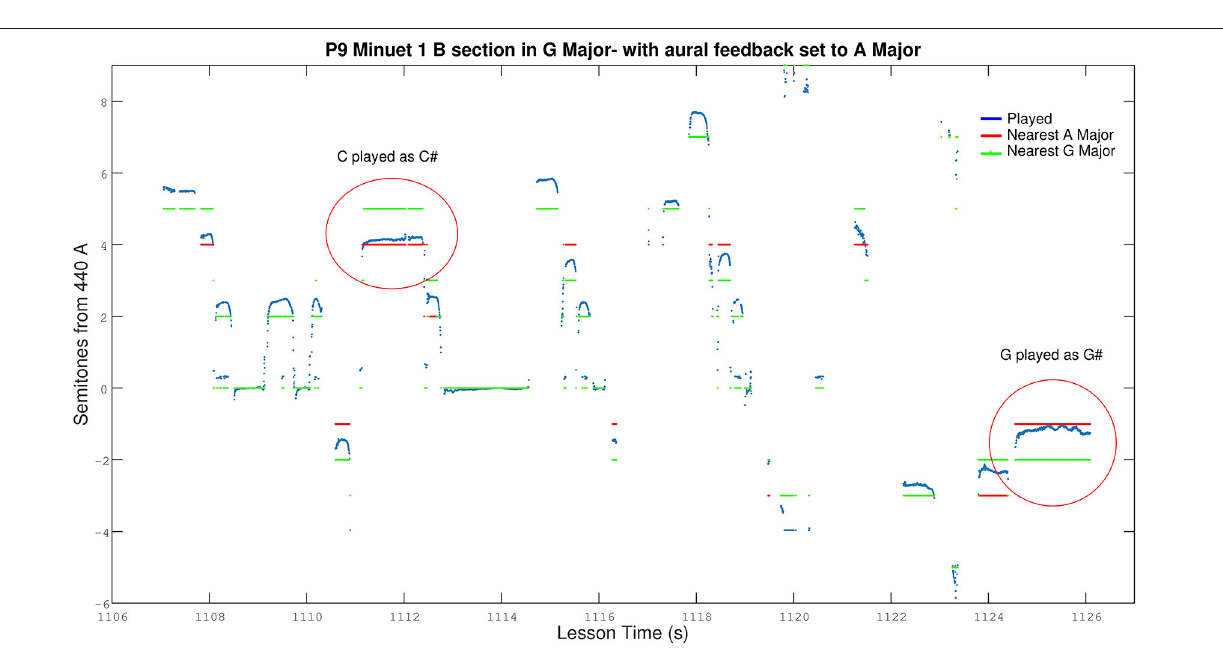
FIGURE 6 | Section of P9 playing Bach’s Minuet 1. Aural feedback is incorrectly set to A Major and P9 can be seen playing closer to C ♯ and G ♯ which feature in A Major, but not in G Major. Red lines represent the nearest note in A Major, and green lines the nearest note in G Major. In the case of the circled C ♯ , the note should be C ♮ but as the played note is sharper than C ♯ , the nearest note in G Major is